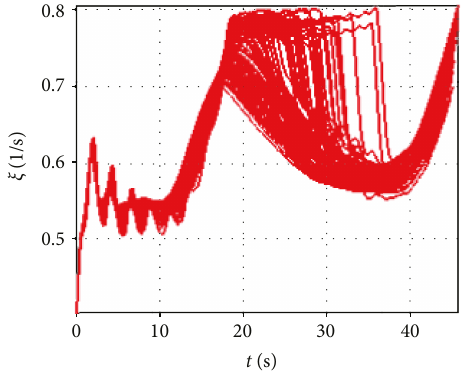
Figure 24: Curves representing the height, velocity, and terminal